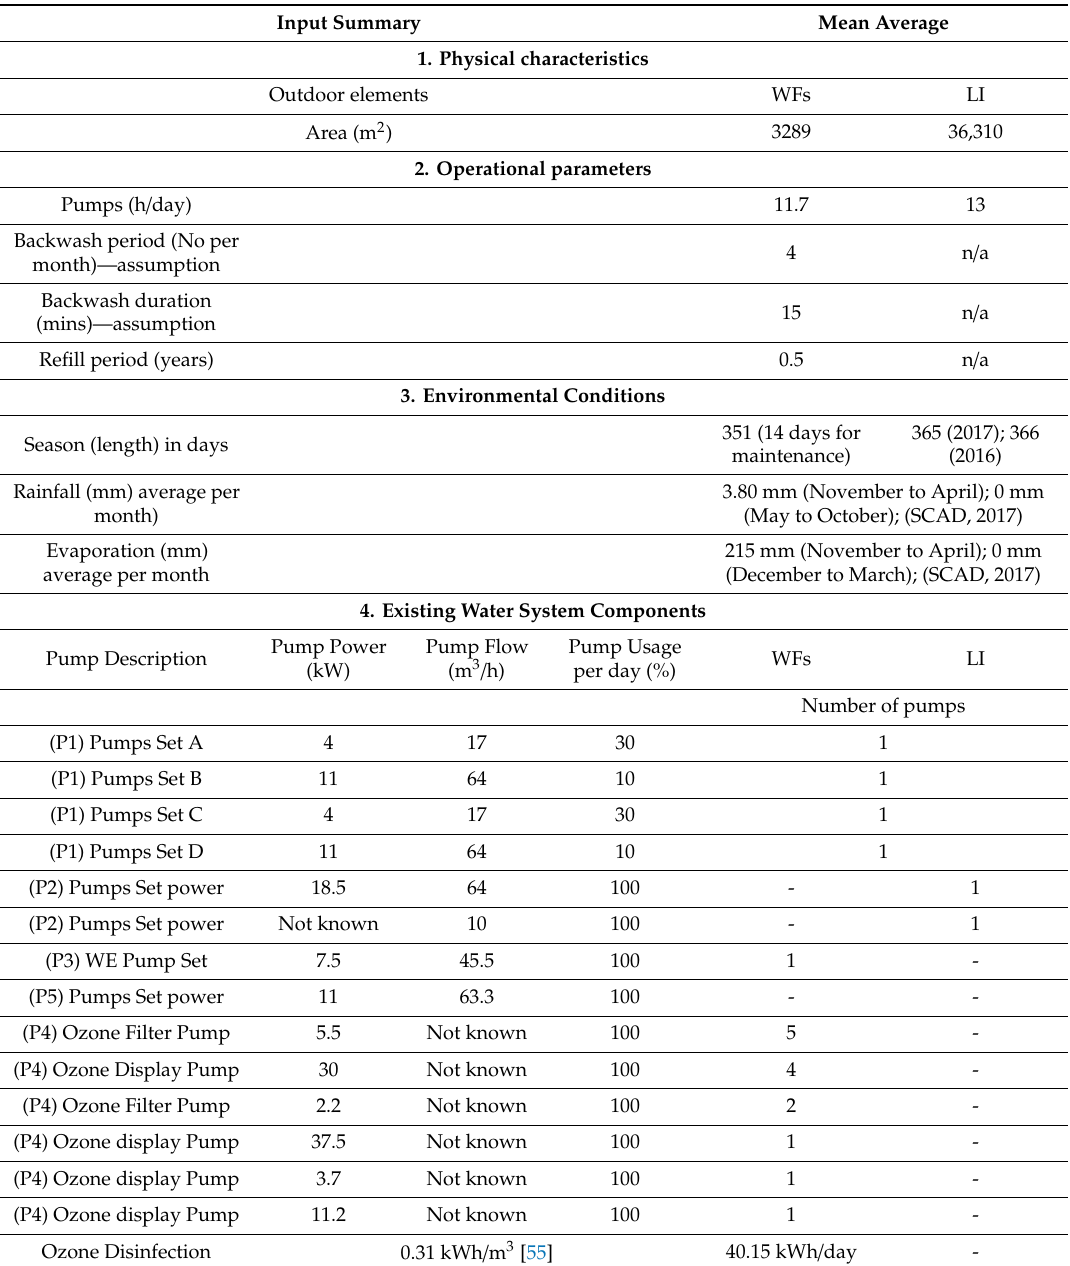
Table A1. Updated MFCS main operation input summary